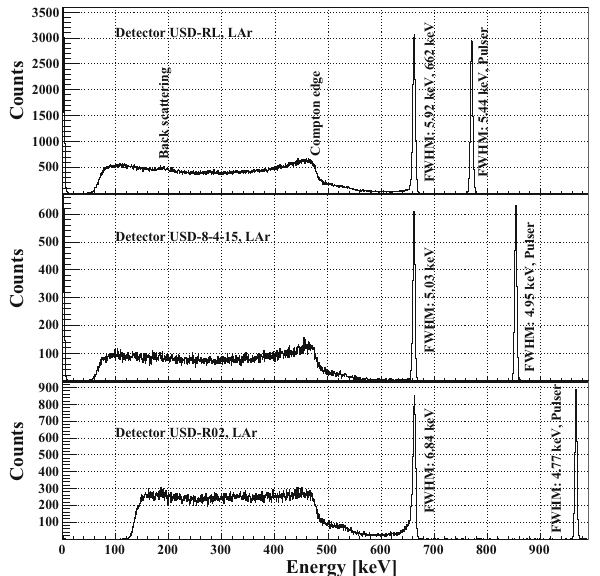
Fig. 15 Energy spectra of 137 Cs taken in LAr